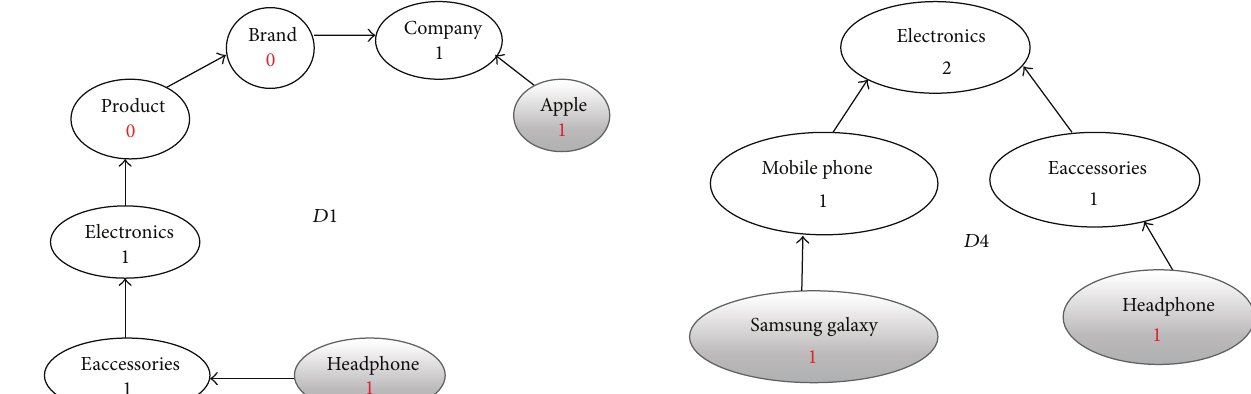
Figure 18: Frequencies after spreading activation for 𝐷4